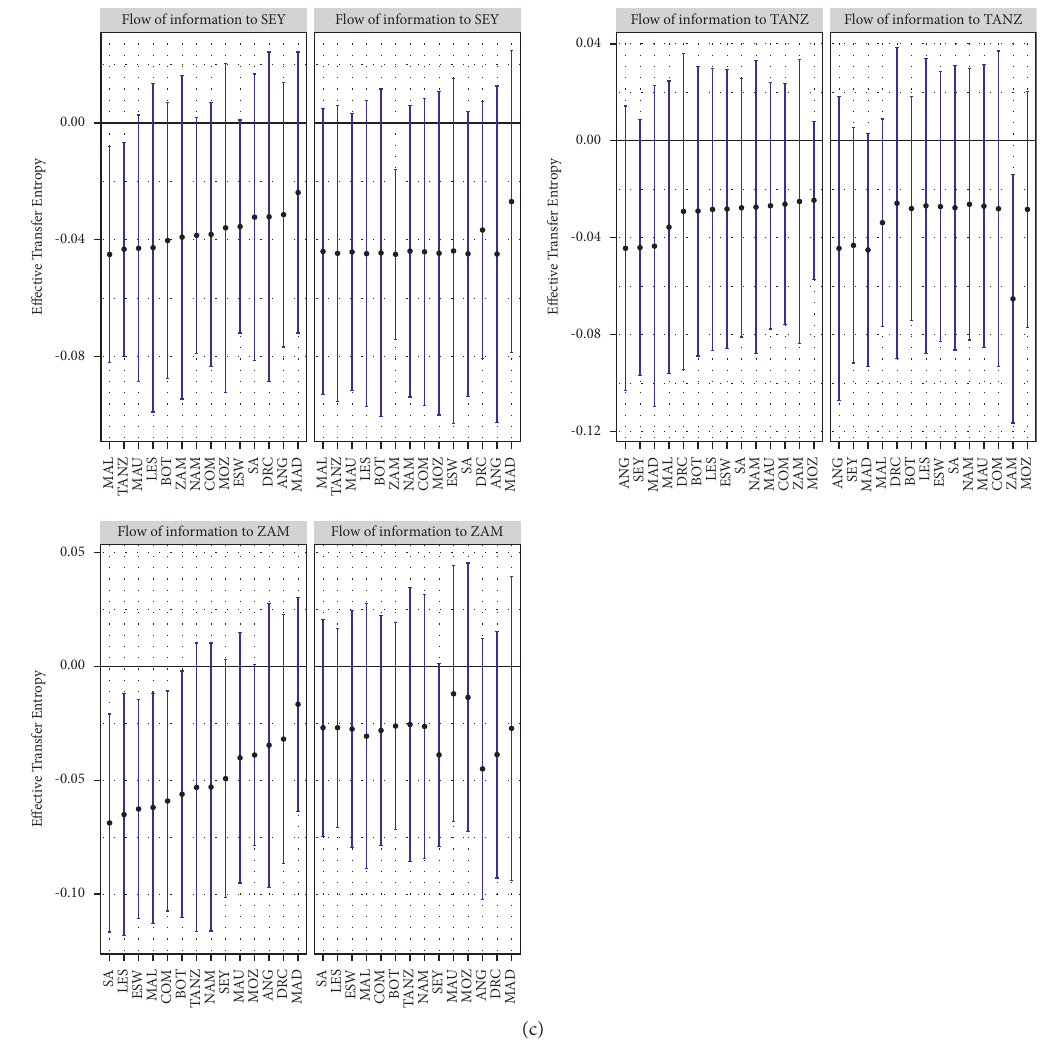
Figure 4: Information flow between exchange rates at low-frequency